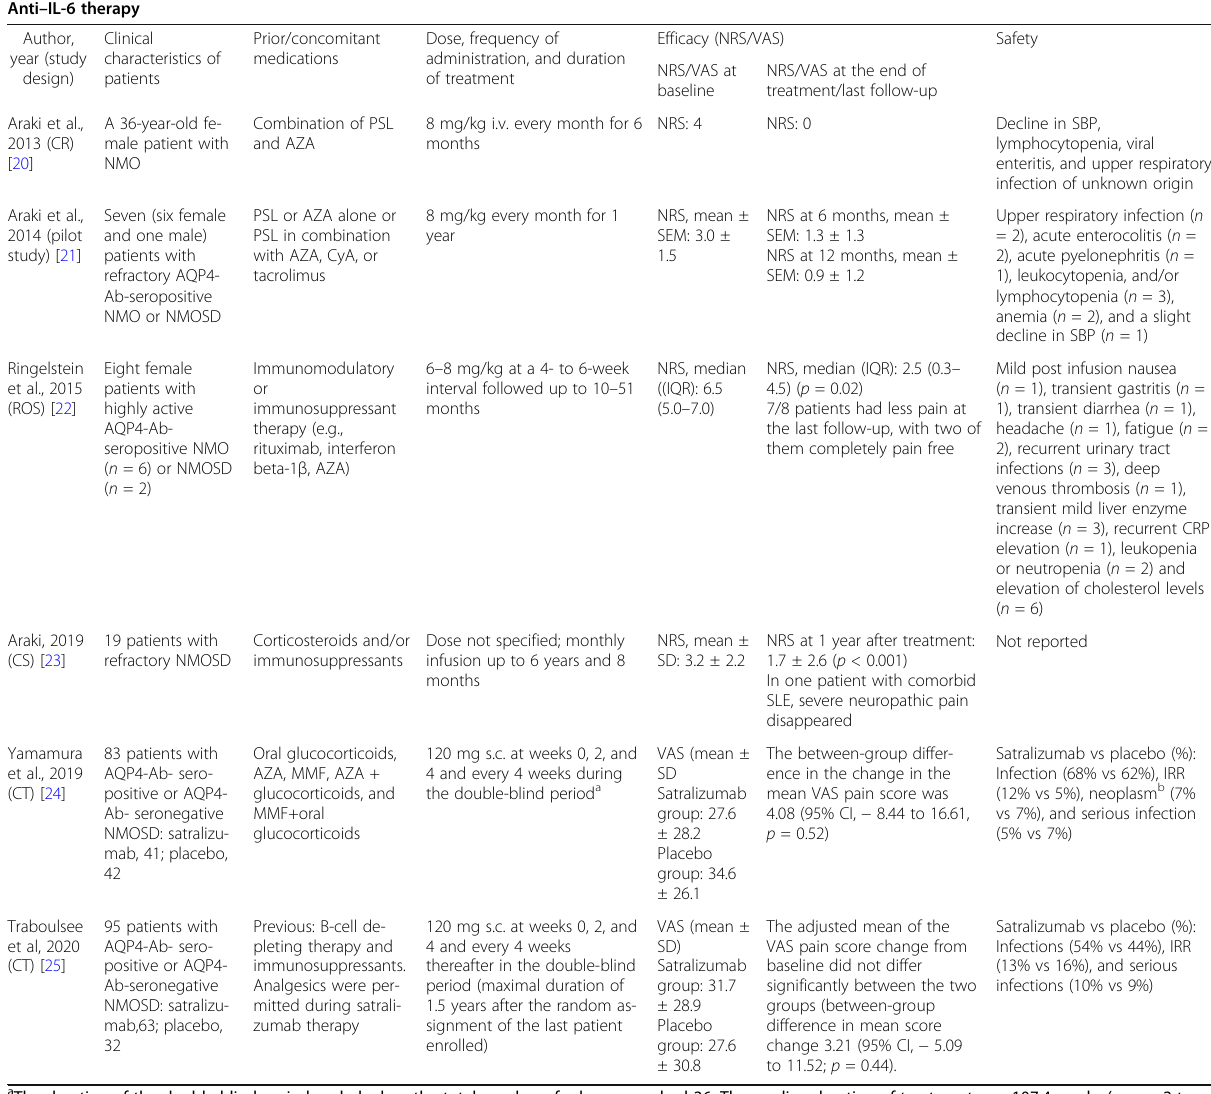
Table 1 Efficacy and safety of anti – IL-6 therapies on neuropathic pain in patients with